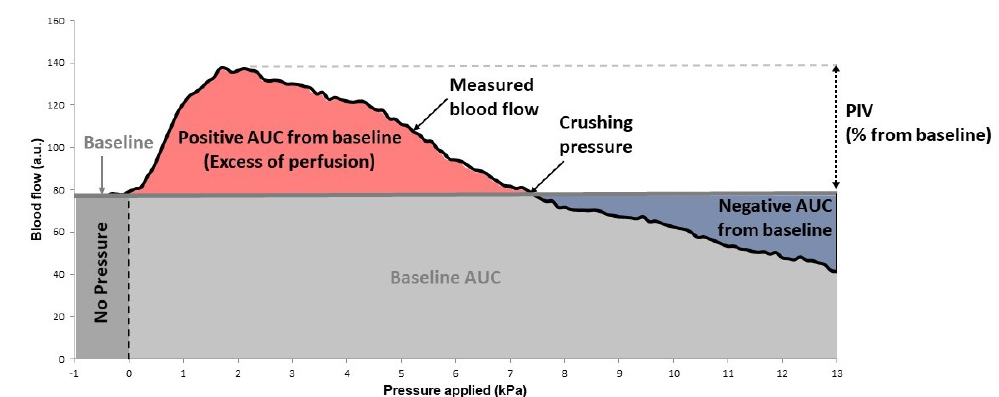
Figure 1. Evolution of the blood flow under pressure application and definition of PIV, along with crushing pressure, positive and negative AUC from baseline.